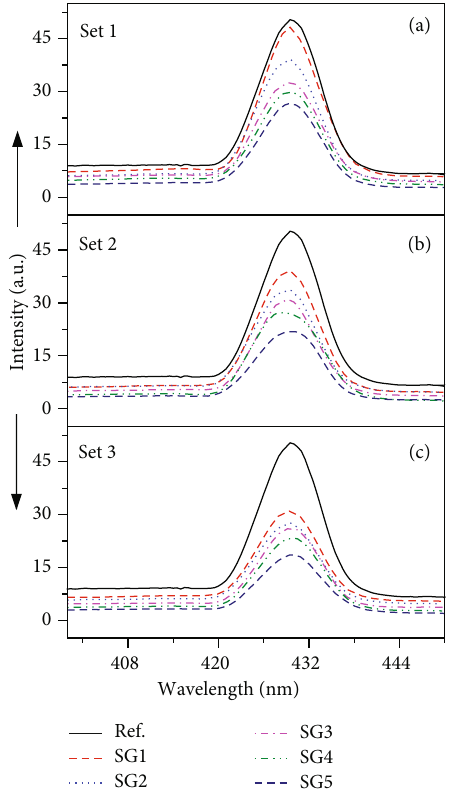
Figure 5: PL spectra (a) for di ff erent gamma dose irradiated, (b) for postalpha irradiated with di ff erent gamma dose, and (c) for prealpha irradiated with di ff erent gamma dose of PM-533 SSNTDs.